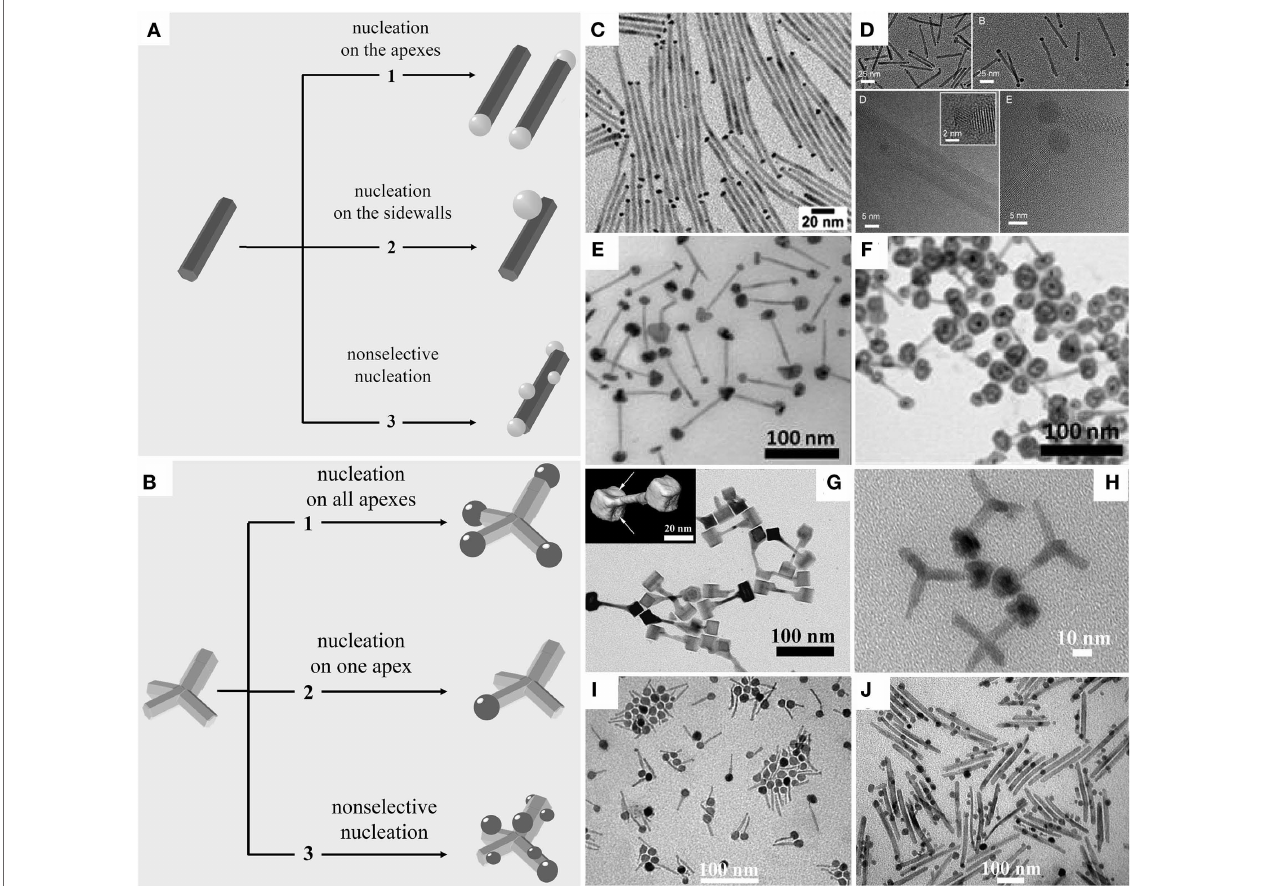
FIGURE 7 | Examples of anisotropic magnetic heterostructured nanocrystals (MHNCs) synthesized by regioselective heterogeneous deposition of secondary materials domains on preformed nanorod and tetrapod seeds . (A,B) Sketch of the mechanism. (C–J) Low-resolution transmission electron microscopy images of: (C) nanodumbbells of NiPt-tipped CdS nanorods [reproduced from Habas et al. (2008) with permission, copyright American Chemical Society]; (D) nanodumbbells of Ni-tipped CdS nanorods [reproduced from Nakibli and Amirav (2016) with permission, copyright American Chemical Society];